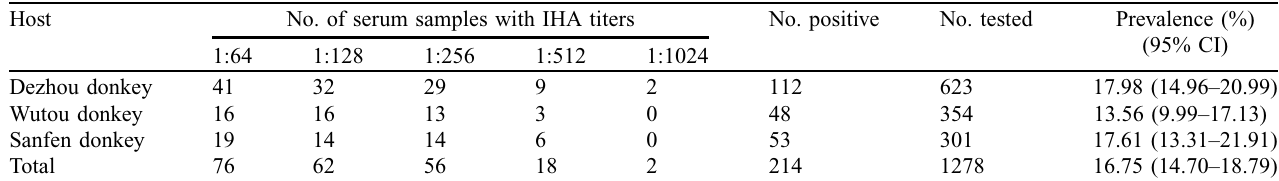
Table 1. Seroprevalence of T. gondii infection in donkeys in Shandong province, eastern China by